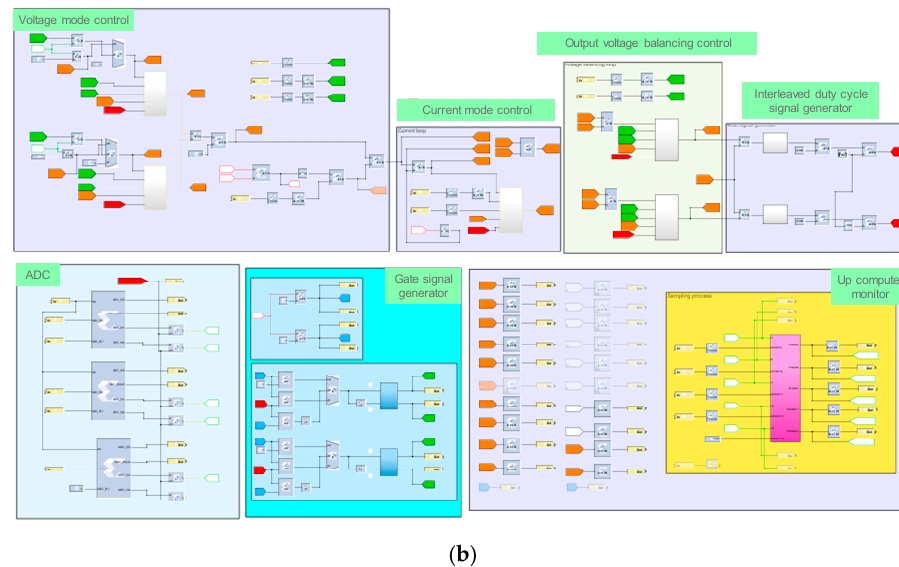
Figure 5. ( a ) Experimental setup of two input series-connected PFC; ( b ) FPGA control block diagram.